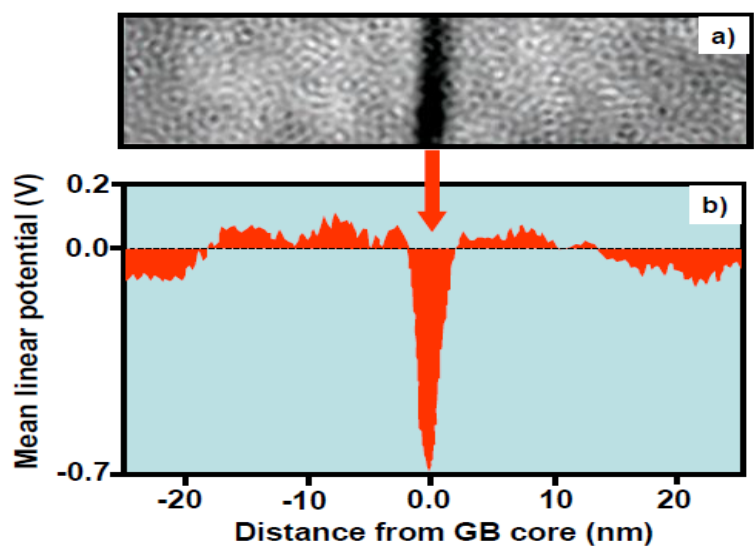
Figure 30. Local map of the variations in the mean inner potential across the bicrystalline boundary ∑ 3(112) of SrTiO 3 crystal ( a ). The colour scale: −0.7 V ( black) and +0.4 V (white). The cross section ( b ) shows a spatial variation of the local potential profile extracted from the map ( a ). Adapted from [91].